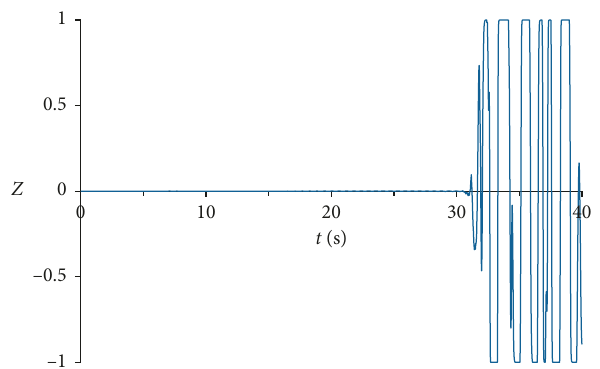
Figure 7: Z function in the case of seismic acceleration recorded during the 2009 L’Aquila